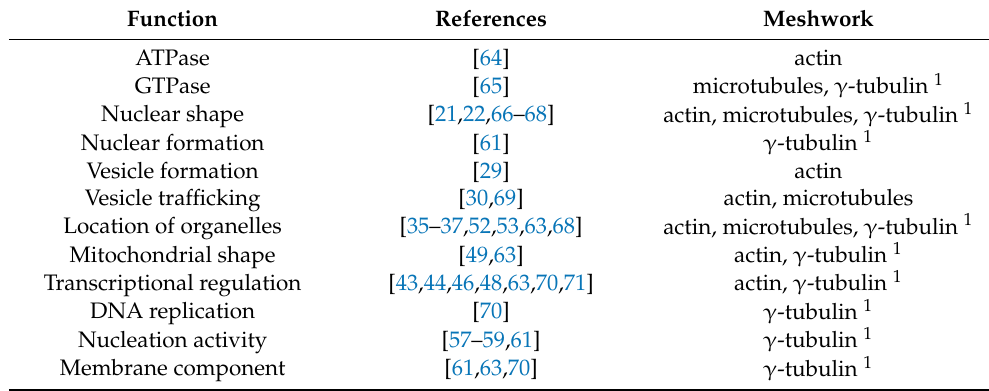
Table 1. Comparison of the cellular functions of actin, microtubules and the γ -tubulin meshwork.